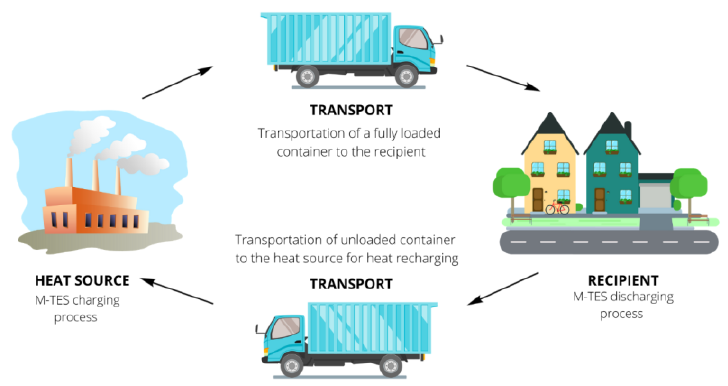
Figure 2. Work cycle of the mobile thermal energy storage system.